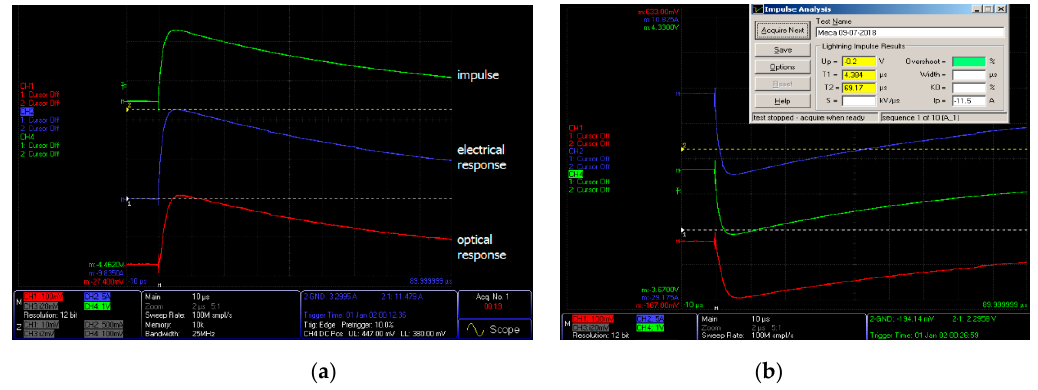
Figure 3. Responses of the OVS sensor embedded in the Medium Voltage Capacitive Divider for applied ( a ) positive and ( b ) negative pulses (20 kVrms, rise time: 4 μ s, green trace): comparison between the Capacitive Divider electrical (blue) and optical (red)